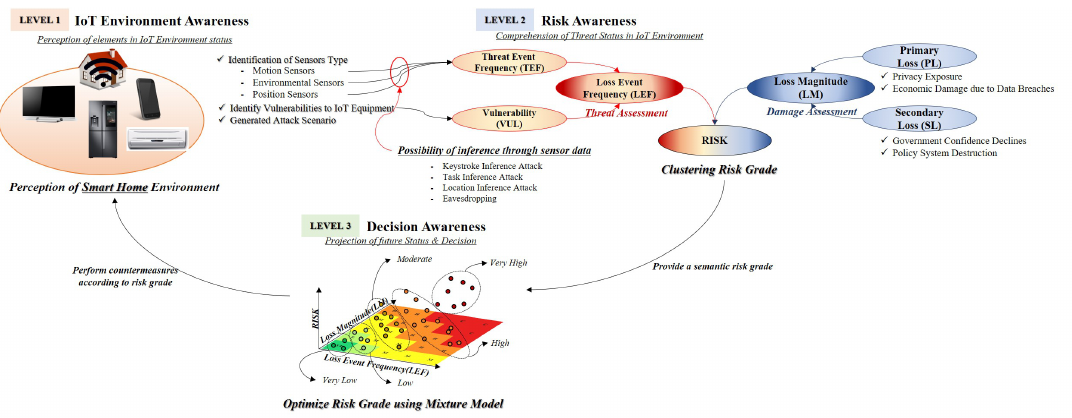
Figure 4. To make decisions about threat of mobile device’s sensors, SA proposed in this paper is composed of three levels: IoT environment awareness ( level 1 ), risk awareness ( level 2 ), and decision awareness ( level 3